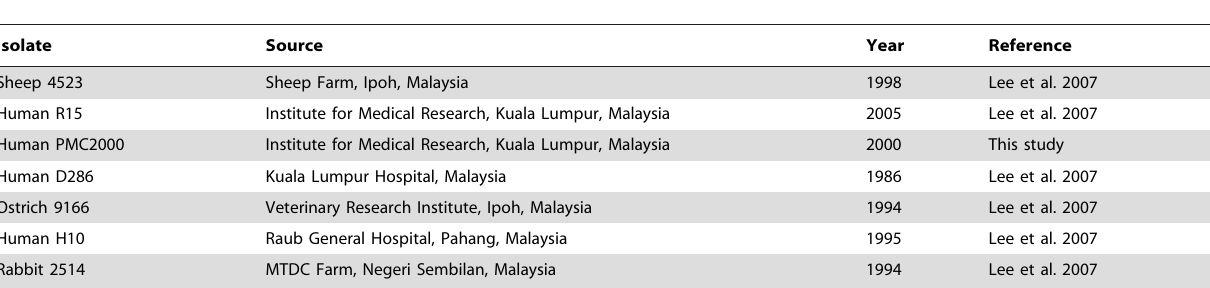
Table 1. Description of B. pseudomallei isolates utilized in this study.